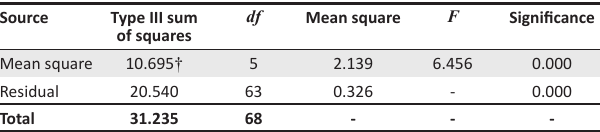
TABLE 5: Tests between venture capital financing and profitability growth effects.